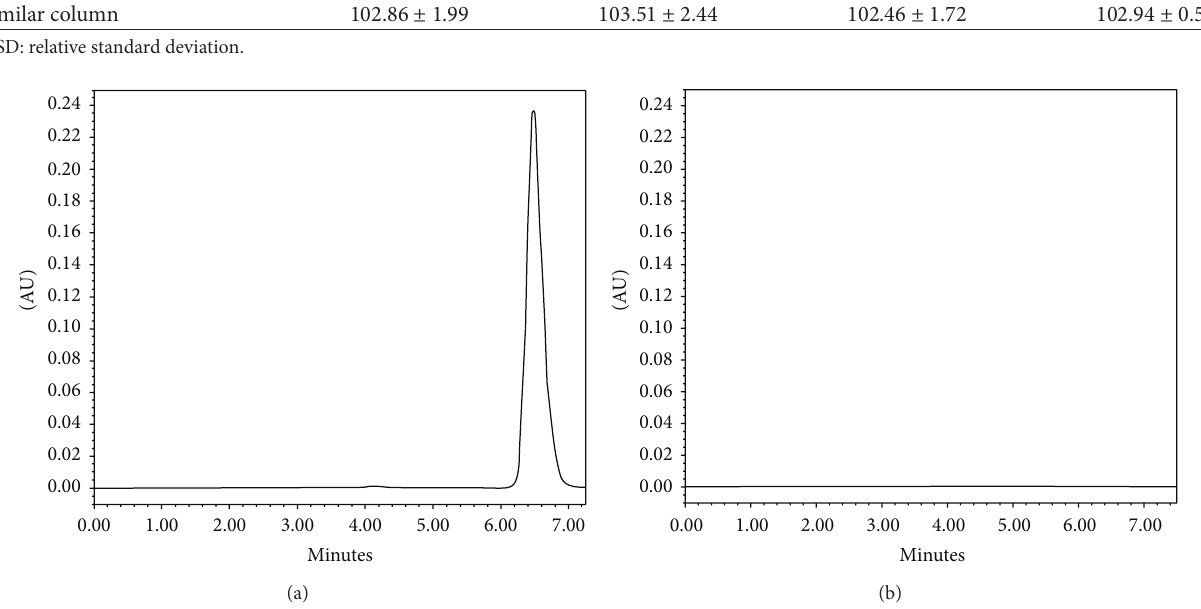
Figure 2: Representative HPLC chromatograms of RVT sample in supernatant from nanoparticles (a) and supernatant from blank nanoparticles(b).Conditions:mobilephase,methanol :water(51 : 49,v/v);flowrate,0.9 mL/min;PDAdetectionwavelength,306 nm;column temperature, 25 ∘ C; injection volume, 20 𝜇